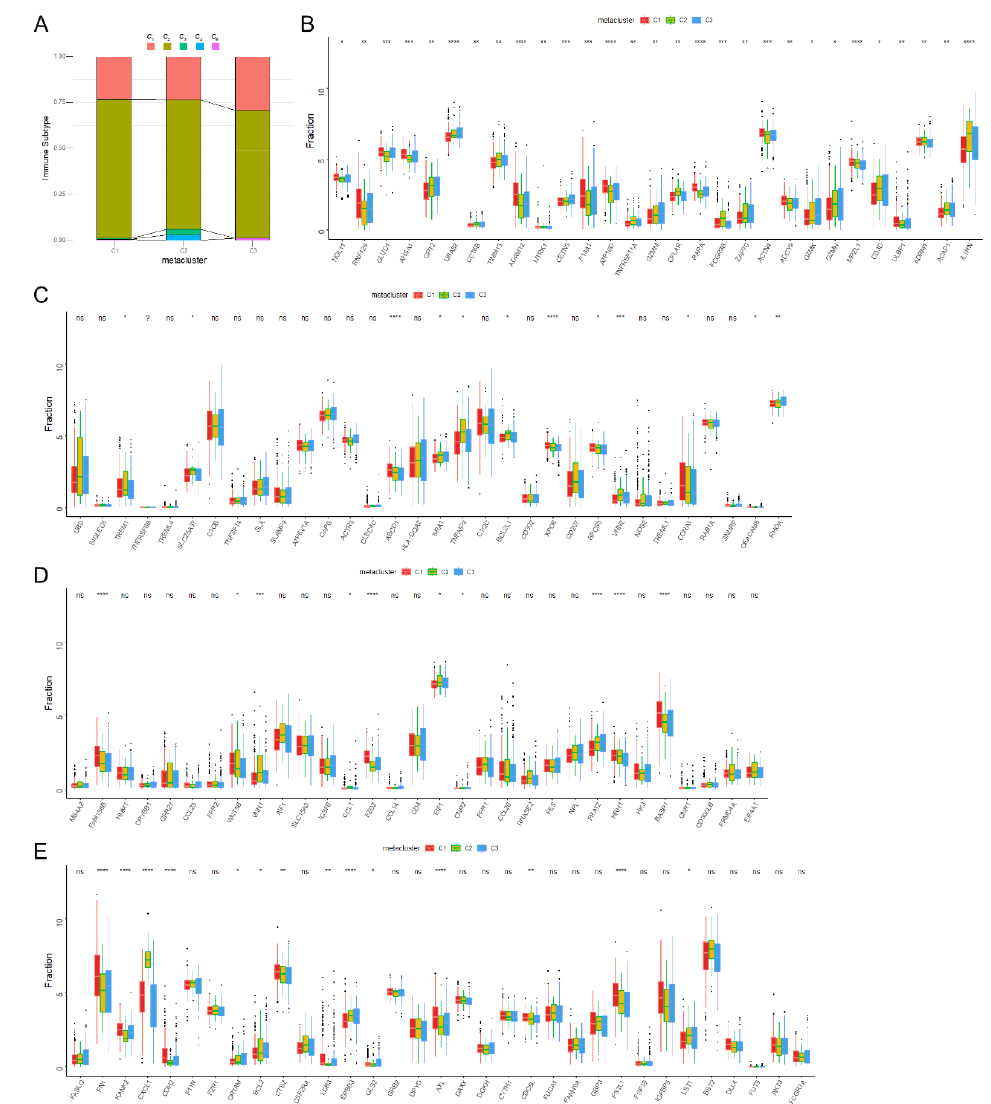
Figure 6. Cellular and molecular characteristics of immune subtypes. ( A ) The correlation between three immune subtypes (C1–C3) from our results and six immune subtypes ( c 1 – c 6 ) from Thomson. Differential expression analysis of activated CD8 T cell-related genes ( B ) and activated dendritic cell-related genes ( C ). Macrophage-related genes ( D ) and NK cell-related genes ( E ) among subtypes. * p < 0.05, ** p < 0.01, *** p < 0.001, and **** p < 0.0001.